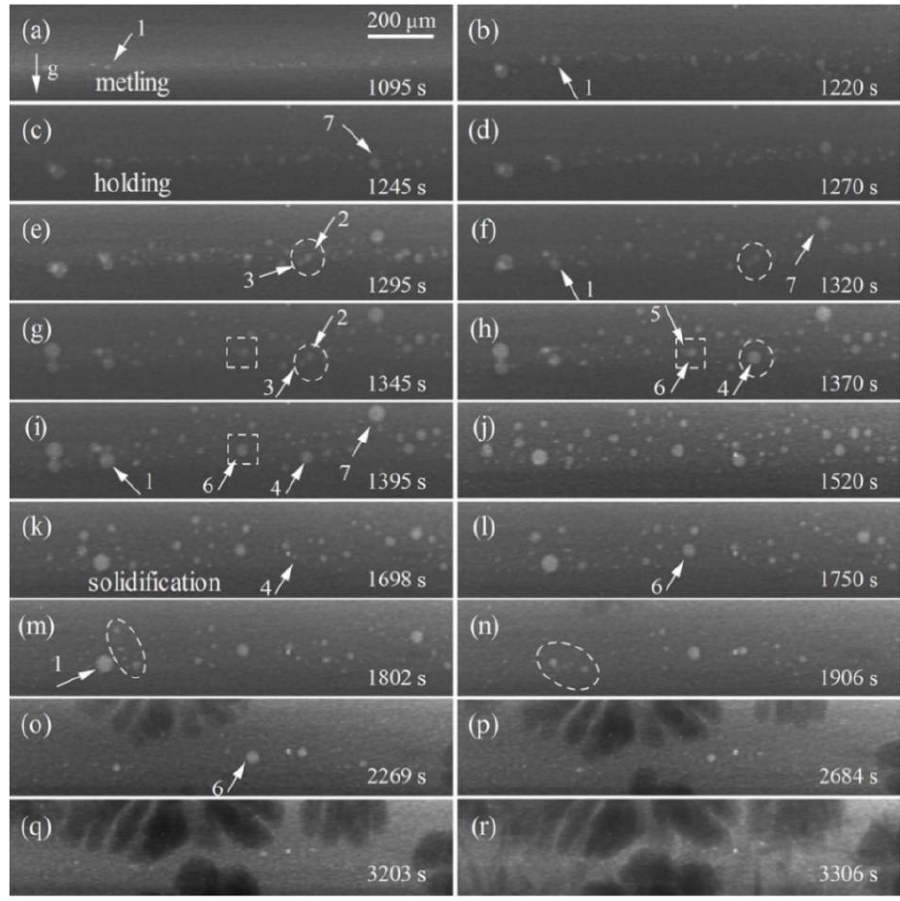
Figure 3. The formation and evolution of bubbles: ( a – b ) the melting process ( t = 0 s is assigned to the onset of image collection at 300 °C), ( c – j ) the holding process, ( k – r ) the solidification process. Bubble floating : The floating up of bubble 7 is also observed at the initial stage of growth, as shown in Figure 3f – i. The bubble is lighter compared to the melt. Thus, the density difference provokes the floating up of the bubble. During the floating process, the bubble was affected by gravity, buoyancy and viscous resistance of the melt, and finally reached equilibrium and stopped floating.